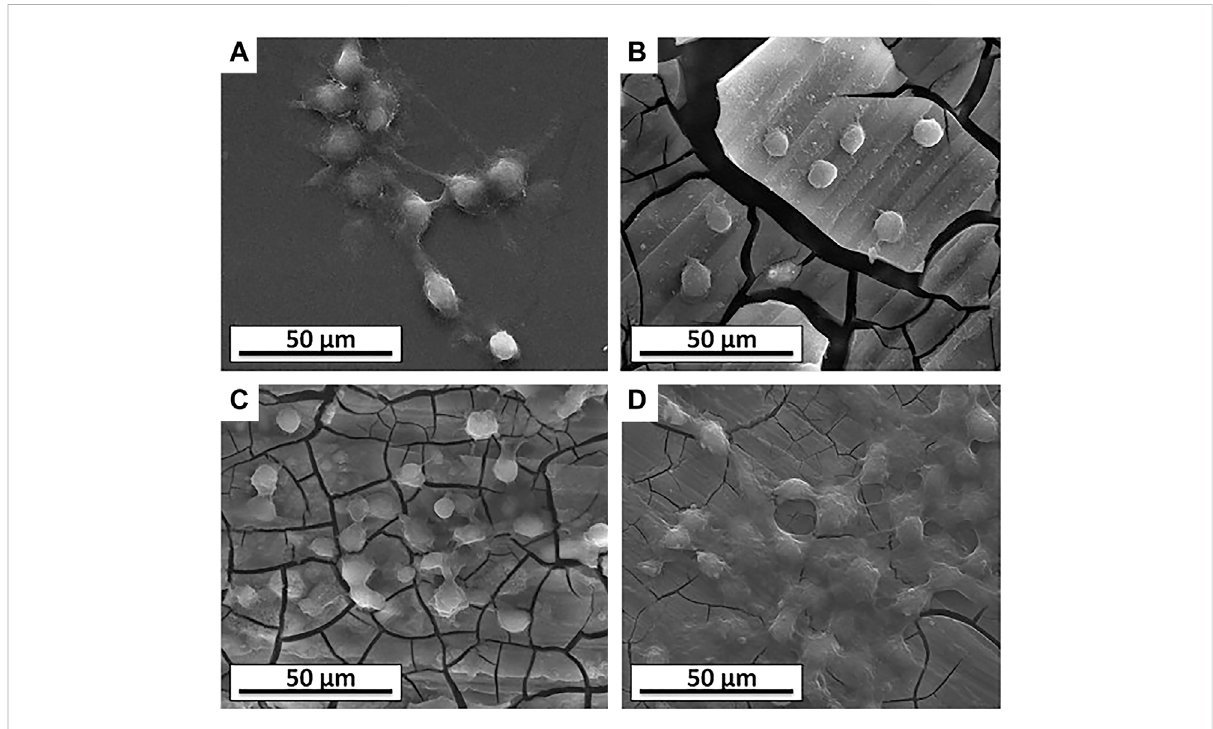
FIGURE 12 SEM morphologies of the L6 cells on the surface of the samples: (A) control, (B) Mg, (C) FSP-Mg, and (D) FSP-Mg-nHA. Reprinted with permission from reference (Sunil et al., 2014a),